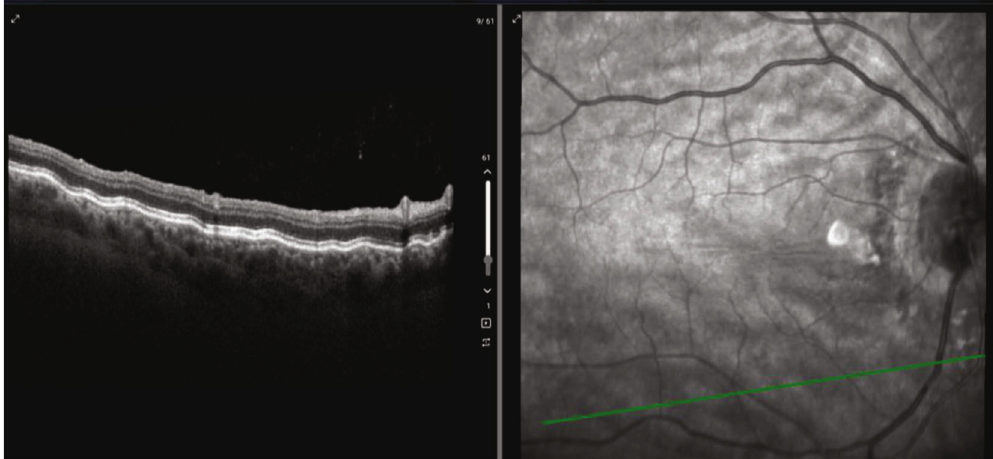
Figure 1: Spectralis OCT of the right macula showing choroidal